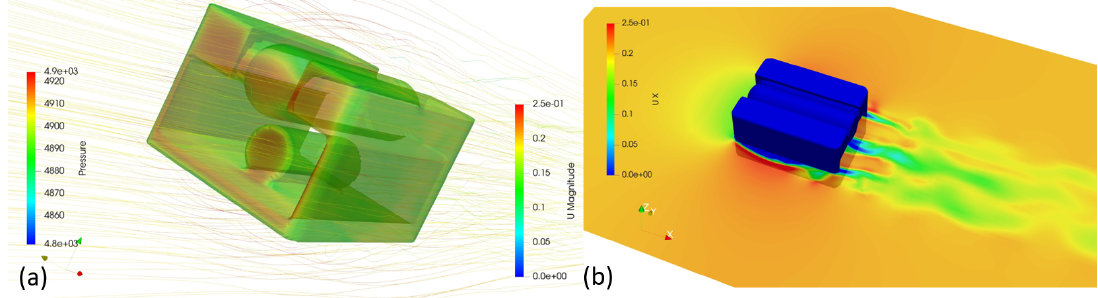
Figure 8. ( a ) Velocity streamlines around the vehicle and pressure on the vehicle; ( b ) Velocity field of the vehicle from the numerical simulation.